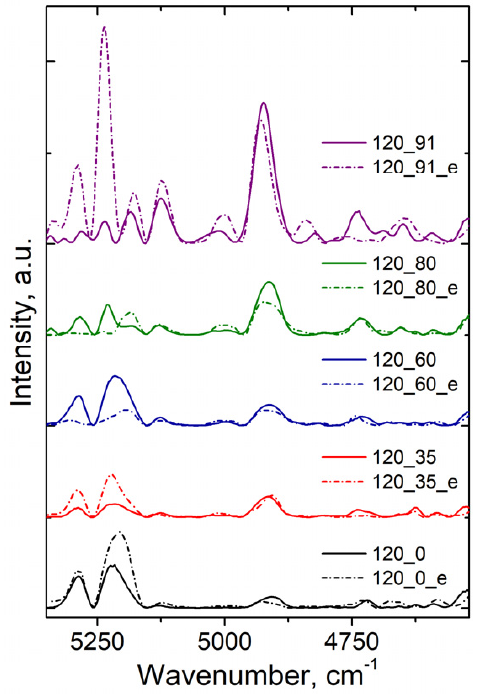
Figure 4. Autocorrelation spectra extracted from the synchronous spectra for the 4520–5350 cm − 1 region (T = 120 °C, RH = 0, 35, 60, 80, 91%, e—extracted).